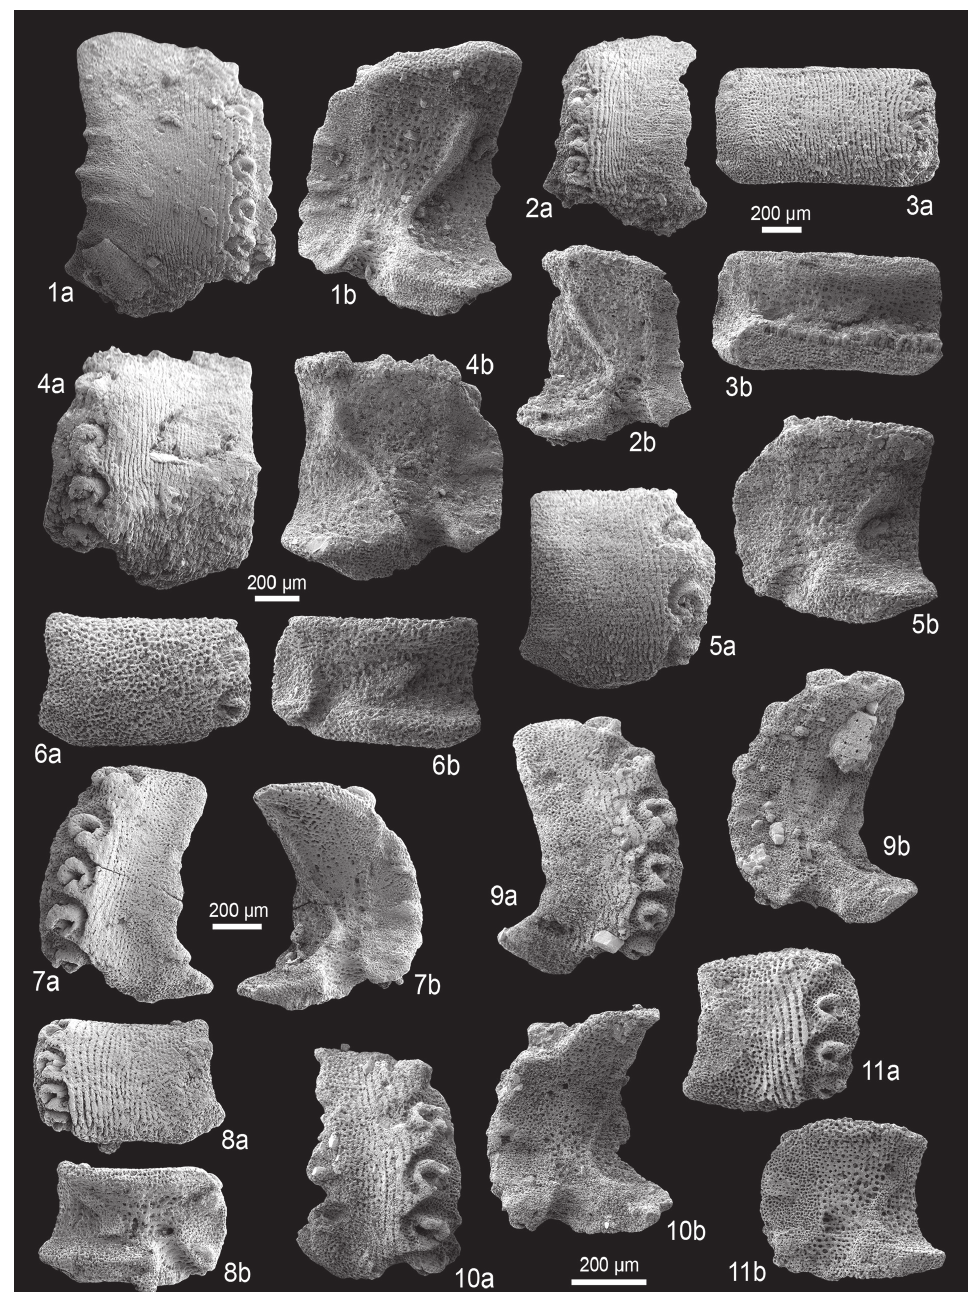
Fig. 26. Fossil lateral arm plates (LAPs) of ophiacanthid brittle stars in external (a) and internal (b) views. 1-3. Dermocoma faberi sp. nov. from the Hettangian (Early Jurassic) of Vance, Belgium. 1. MnhnL HE408 (holotype), proximal LAP. 2. MnhnL HE409 (paratype), median LAP. 3. MnhnL HE410 (paratype), distal LAP. 4-6. Dermocoma potti sp. nov. from the late Pliensbachian (Early Jurassic) of Feuguerolles, France. 4. GZG.INV.78675 (holotype), proximal LAP. 5. GZG.INV.78676 (paratype), median LAP. 6. GZG. INV.78677 (paratype), distal LAP. 7-8. Dermocoma toarcensis (Hess, 1962) comb. nov. from the late Toarcian (Early Jurassic) of Seewen, Switzerland. 7. NHMB M11216, proximal LAP. 8. NHMB M11217, distal LAP. 9-11. Dermocoma longwyensis sp. nov. from the early Bajocian (Middle Jurassic) of Longwy, France. 9. GZG.INV.78679 (holotype), proximal LAP. 10. GZG.INV.78680 (paratype), median LAP. 11. GZG.INV.78681 (paratype), distal LAP. One common scale bar per